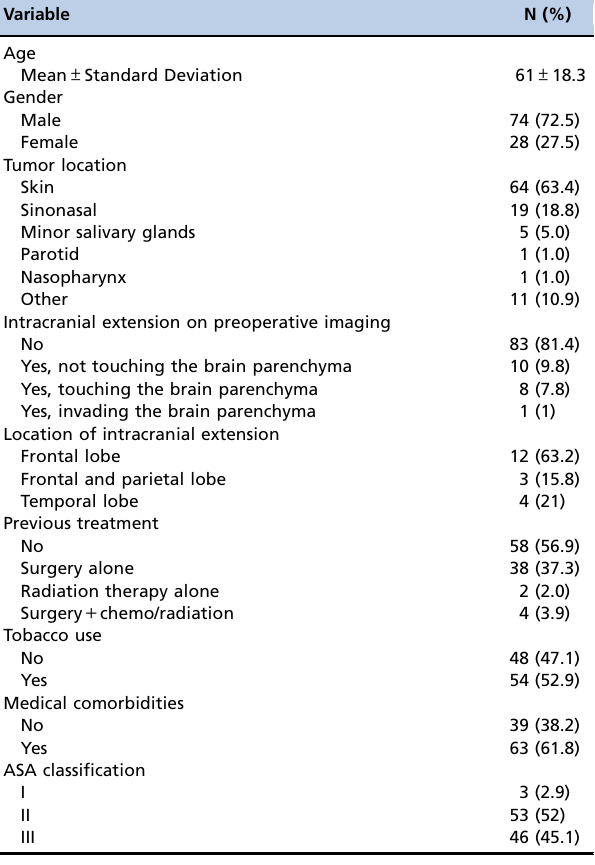
Table 1 - Patient and tumor